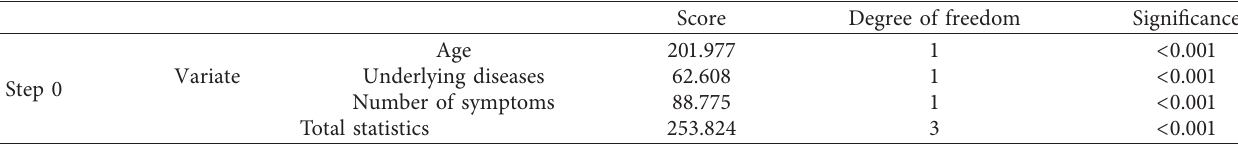
Table 8: Comparison of factors affecting the COVID-19 patients developing severe illnesses after